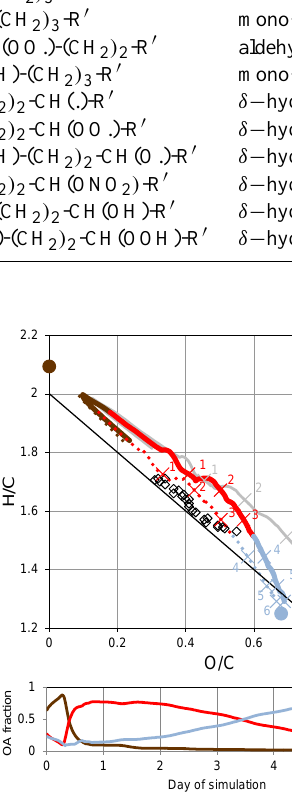
Fig. 10. Van Krevelen diagram showing the evolution of elemen- tal ratios in modeled P OA during both Eulerian (before 15:00 on day 1) and Lagrangian phases of the simulation. BGOA com- position is defined as the mean of regional surface observations (Jimenez et al., 2009), except for the grey line which defines BGOA as the mean of airborne observations (Heald et al., 2010; after Aiken et al., 2008). The dotted line shows OA evolution if ratios count only one O atom per ONO 2 group. Midnight values for each of the 6 days of simulation are indicated by numbered diagonal ticks. Observations are hourly means of measurements at T0 (Aiken et al., 2008). The − 1 slope is included for illustrative purposes. The lower panel shows the development of fractional mass contributions of the different OA types to P